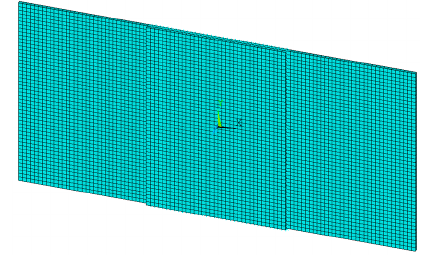
Figure 9. Finite element model.